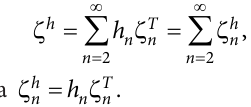
(Burša, Kostelecky 1999).